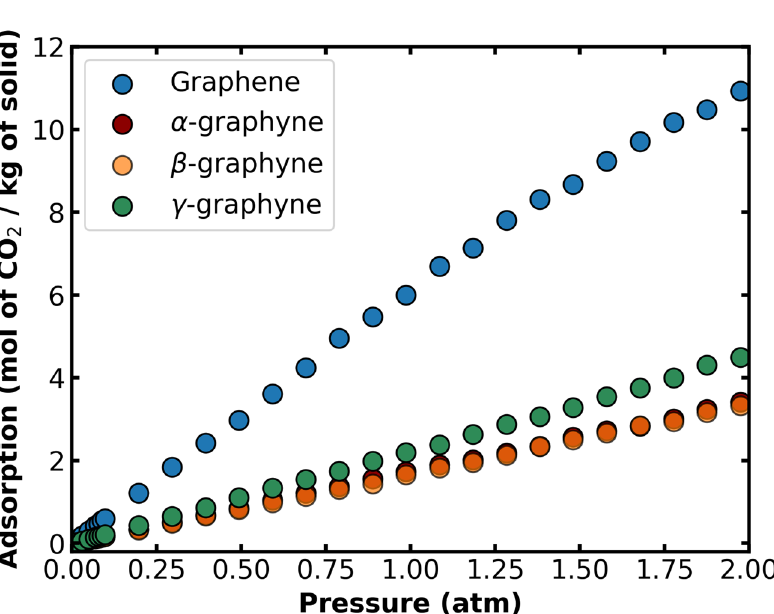
Figure 3. Adsorption isotherms of CO 2 on graphene and the three graphynes without strain (T = 298 K). The isotherms of α - and β -graphyne overlap, and it is hard to differentiate